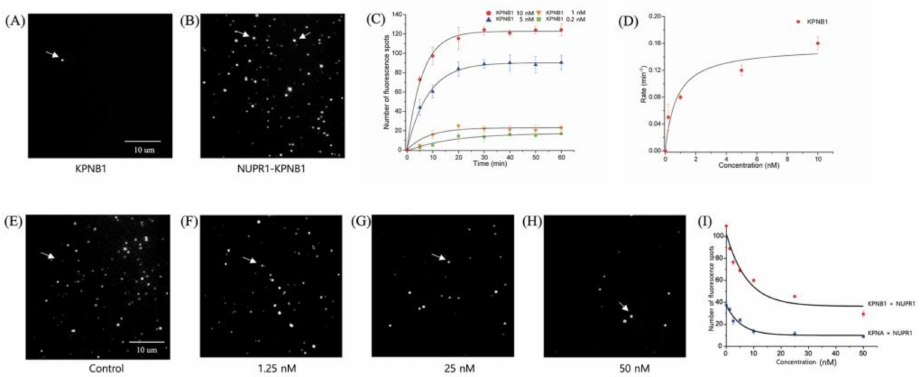
Figure 6. Single-molecule binding assay. ( A ) Karyopherin β 1 (5 nM) was rarely bound to the imaging surface in the absence of immobilized NUPR1 protein. ( B ) Significant increase in karyopherin β 1 (5 nM) binding to the NUPR1-immobilized quartz surface. ( C ) Number of NUPR1-binding spots over time at various concentrations of karyopherin β 1. ( D ) The apparent dissociation rate constants obtained at different concentration of karyopherin β 1, yielding a Km of 0.75 nM after fitting to a Michaelis–Menten equation. ( E – H ) Single-molecule fluorescence images showing karyopherin β 1 binding to the NUPR1-immobilized imaging surface in the presence of various concentrations of ATZ-502: ( E ) 0; ( F ) 1.25; ( G ) 25; and ( H ) 50 nM. ( I ) Karyopherin β 1 and karyopherin α binding to the NUPR1-immobilized imaging surface was monitored in the presence of various concentrations of ATZ-502. Karyopherin β 1 and karyopherin α were preincubated with ATZ-502 for 30 min on ice. White arrow, NUPR1–karyopherin β 1 binding